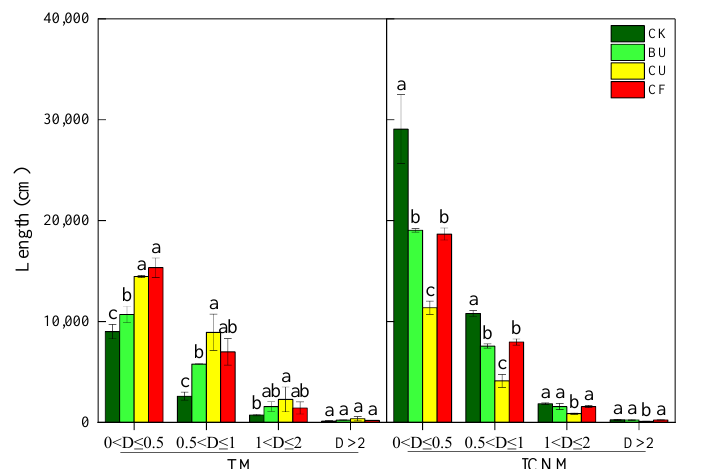
Figure 3. The length classification of root with different diameters. Different lowercase letters indicate significant differences at p = 0.05, the same below.